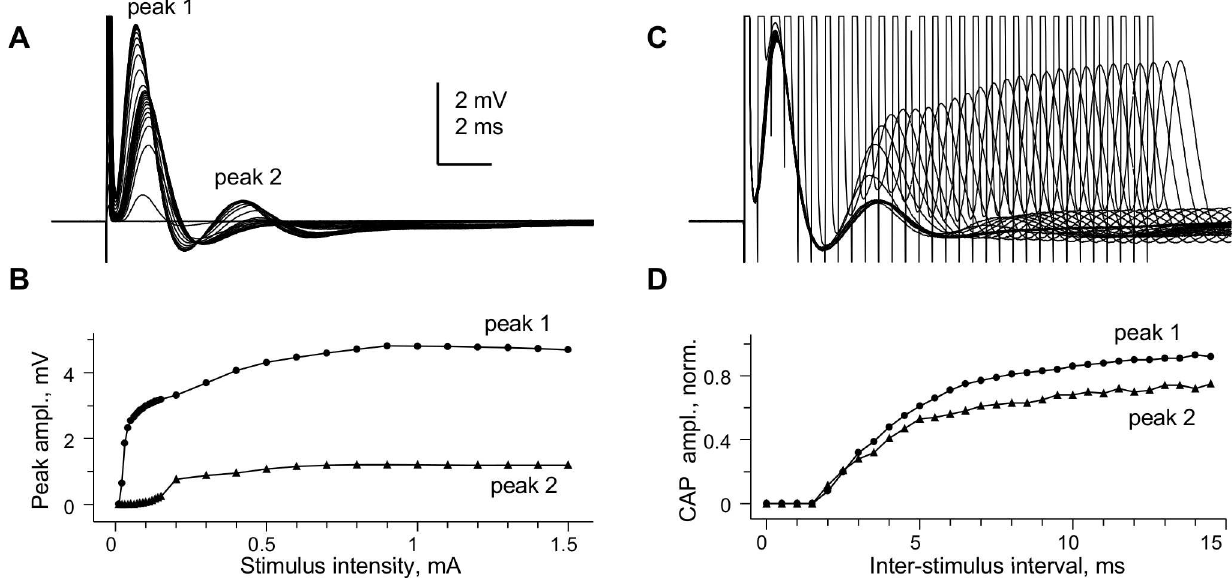
Fig 2. Stimulus-response relationship and refractoriness of “whole” CC compound action potential peaks. This figure shows further details on “whole”CC CAP from in Fig 1C. (A) Superimposed CAPs recordedat varyingstimulus intensities.(B) stimulus-responseplot of amplitudesof peaks 1 and 2 for CAPs shown in (A). (C) SuperimposedCAPs evoked by pairedstimuli of varyingintervals, with 0.5 ms interval increments. Individual traces in (B) and (C) are averagedfrom 6 consecutive recordingsat each stimulationintensity, taken at 10 s intervals. (D) Plot of peak amplitudesof 2 nd CAP in the pair as a function of inter-stimulus interval, normalizedto peak amplitudes of the 1 st CAP in the pair. The absoluterefractory periodof both peaks is 1.5 ms, while the relativerefractory periodof both peaks exceeded15 ms. Conduction distance1.5 mm; room